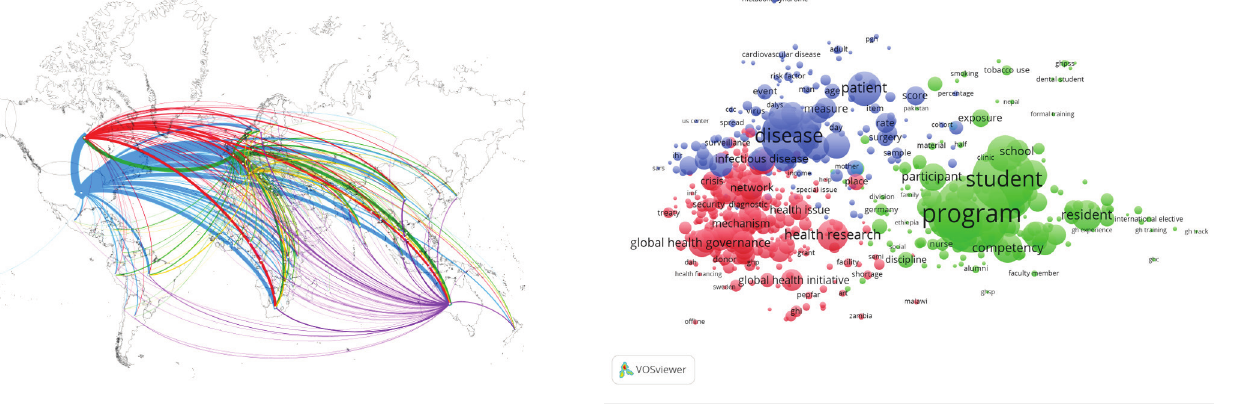
Figure 3. Map of Research Collaboration for the 5 Countries With Most Authorship Links.